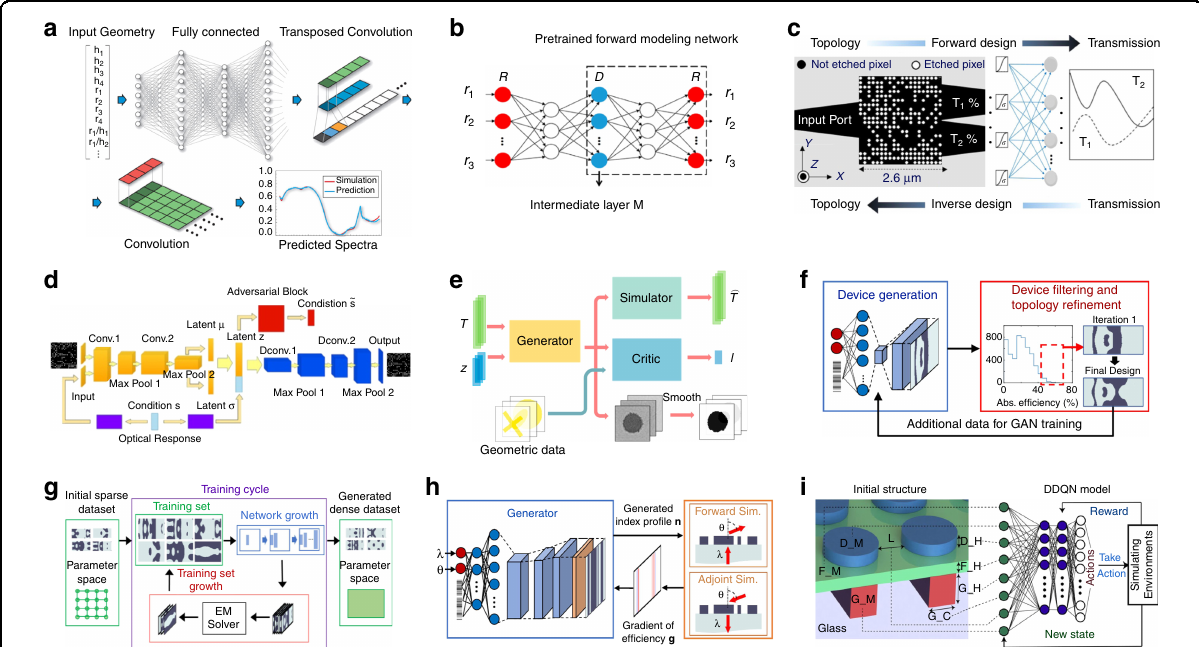
Fig. 12 Arti fi cial neural networks for nanophotonic inverse design. a – c Inverse design with discriminative ANNs. a A convolutional neural network (in conjunction with DBS algorithm) for designing all-dielectric metasurface 439 . b Tandem network (an inverse network connected to a pretrained forward modeling network) for designing multiple thin fi lm stacks 440 . c Meta-waveguide inversely designed by residual deep neural network (ResNet) 487 . d – h Generative ANNs. d A conditional VAE network for designing analog power splitters with various splitting ratios 61 , where etch hole positions are the design space. e A GAN network for metasurface that supports tailored transmission spectral responses 448 , with three networks: the generator, the simulator, and the critic. f A conditional GAN network for designing meta-grating 449 . g A modi fi ed GAN network consisting of three principal features: progressive network growth, the self-attention mechanism, and progressive growth of the training set 450 . h A global topology optimization network (GLOnet) 452 . Optimization is done by coupling a generative network with direct electromagnetic solver. i Inverse design of metasurface hologram with reinforcement learning 457 . Initial structure used as the input double deep Q-learning network (DDQN) at each step. Panels adapted from: OSA ( a ) 439 ; ACS ( b 440 , e 448 , f 449 , g 450 , h 452 ); Springer Nature ( c 487 , i 457 ); Wiley ( d ) 61